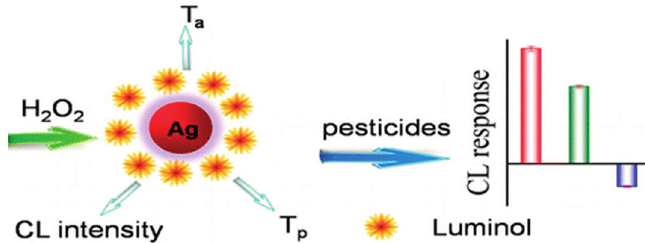
Figure 11. Chemiluminescence-based detection of pesticides using Lum-functionalized AgNPs (reprinted with permission from [128]; copyright 2015 American Chemical